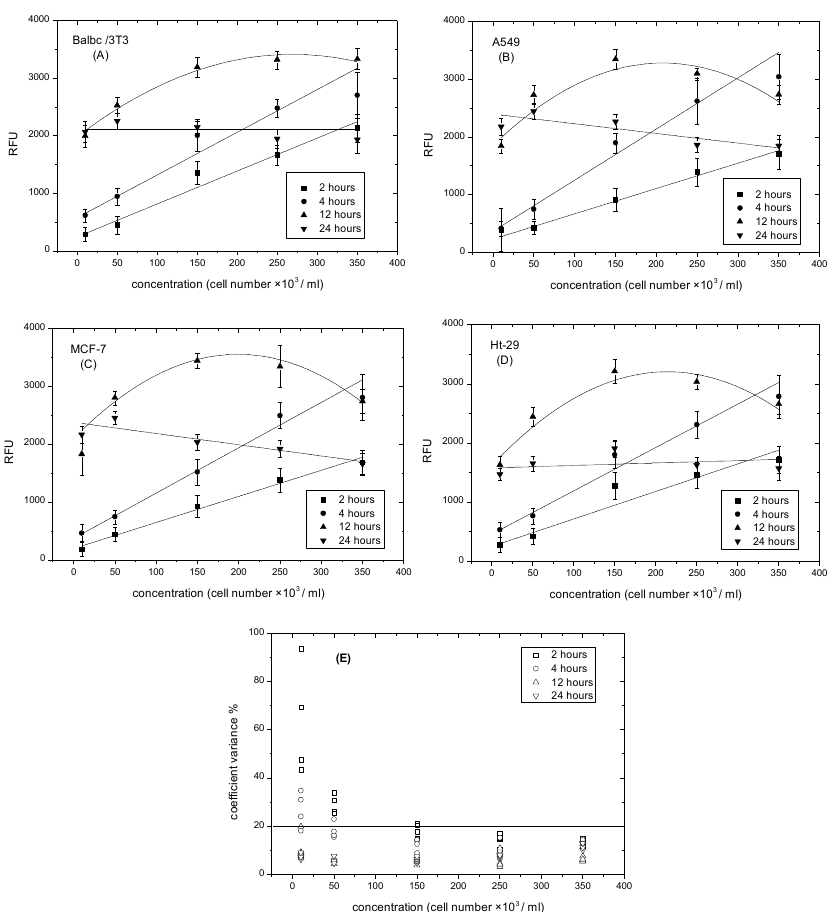
Figure 3. E ff ect of incubation time on fluorescence intensity measured during resazurin reduction. ( A ) Balbc / 3T3 cell lines; ( B ) A549 cell lines; ( C ) MCF-7 cell lines; ( D ) Ht-29 cell lines; ( E ) Coe ffi cient variance % of incubation time vs. cells numbers. Data are expressed as the mean ± SD of the measurements of three independent experiments.